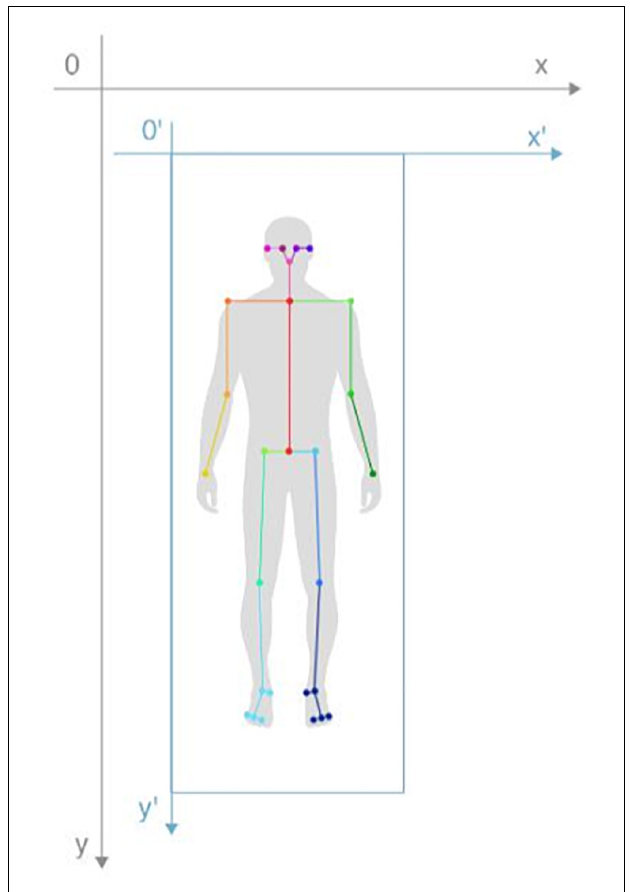
FIGURE 3 | Keypoint position signal normalization